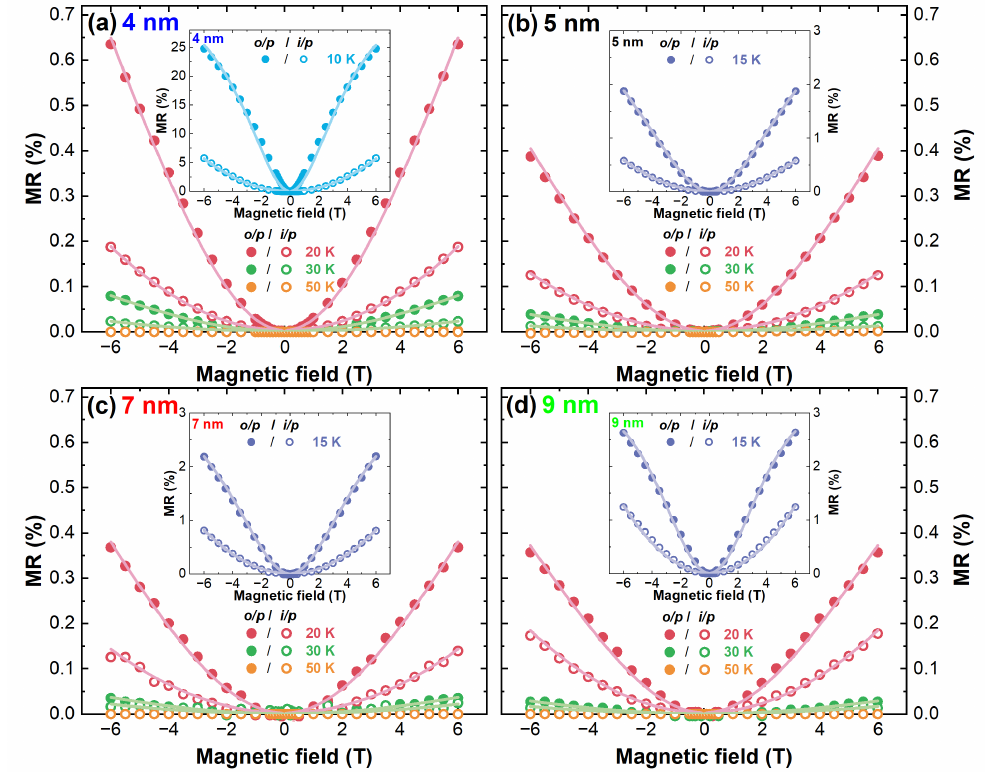
Figure 4. Measured and modelled out-of-plane ( o/p , closed symbols) and in-plane ( i/p , open symbols) magnetoresistance (MR) in % above T c at 10 K, 20 K, 30 K, and 50 K for ( a ) 4 nm, and at 15 K, 20 K, 30 K, and 50 K for ( b ) 5 nm, ( c ) 7 nm, and ( d ) 9 nm NbN thin films on sapphire in the magnetic field range from − 6 T to +6 T. Sheet resistance measurements at 50 K revealed zero MR for all the samples. The magnetoresistance at 50 K lay below the measurement resolution limit (3 × 10 − 3 %).